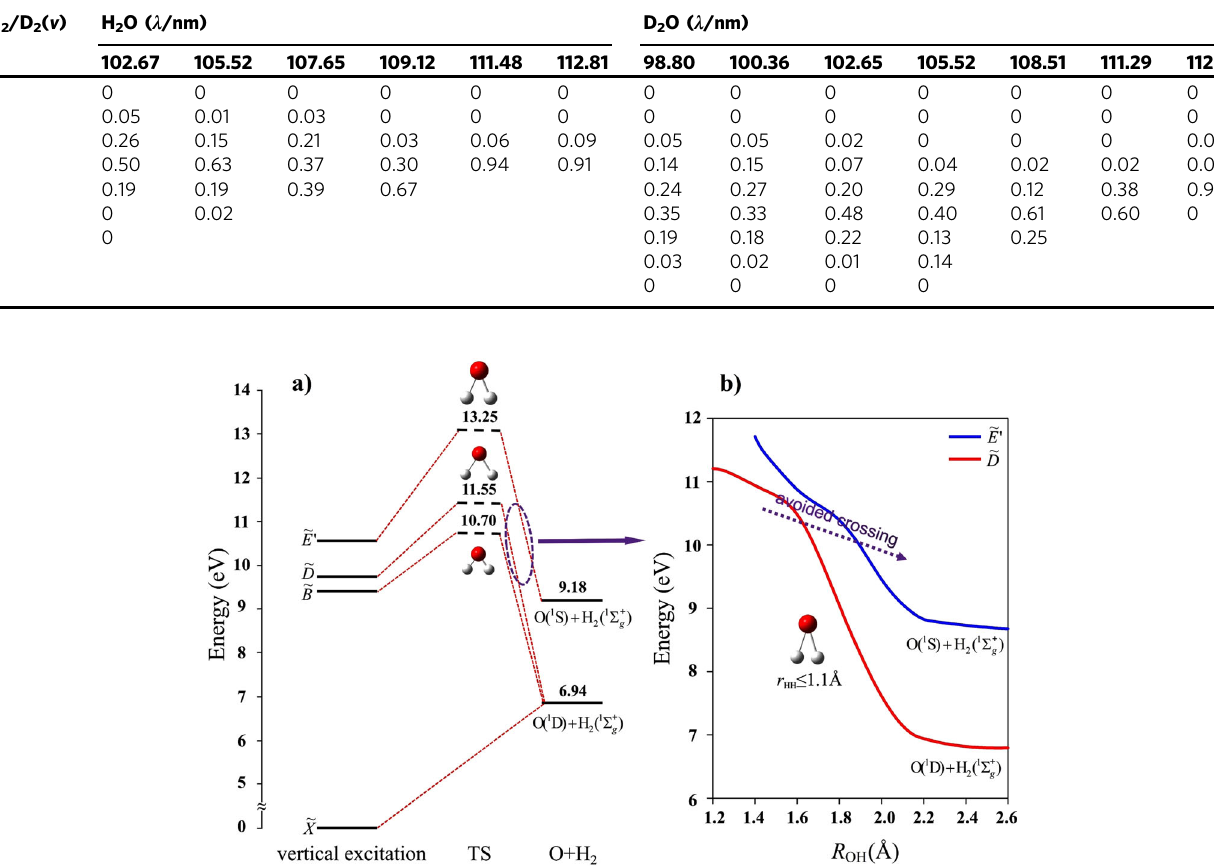
Table 1 The relative vibrational state populations of H 2 (D 2 ) photofragments for the O( 1 S) + H 2 (D 2 ) channel following H 2 O (D 2 O) photolysis in the wavelengths range of 100 – 112 nm. The sum populations of all vibrational states have been normalized to unity.